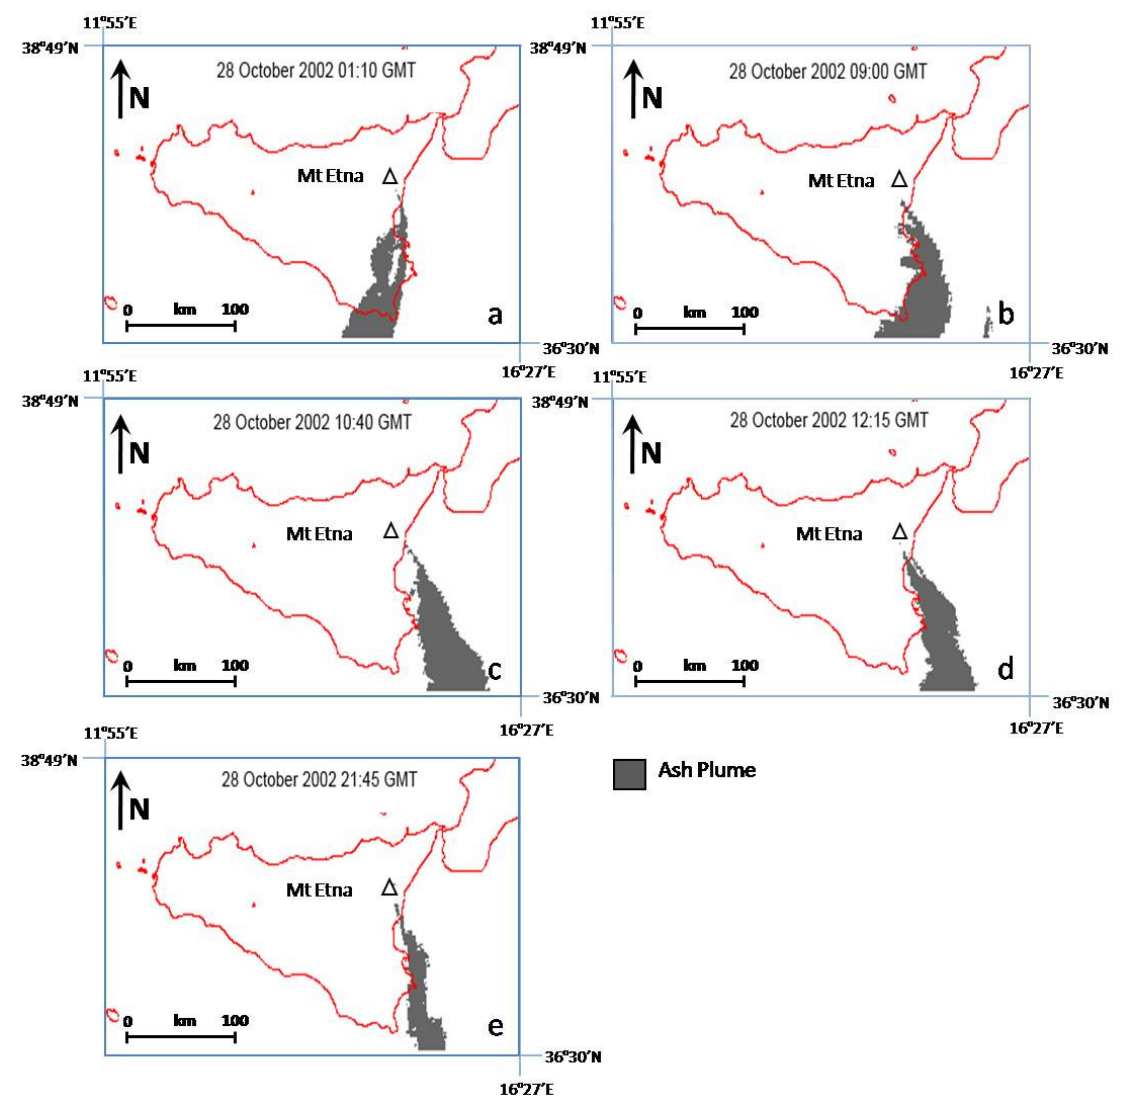
Figure 4. Temporal sequence of RTS ash products (grey pixels) generated processing all the MODIS records acquired on 28 October 2002 over Mt. Etna area (the white triangle in the figure). Red lines represent